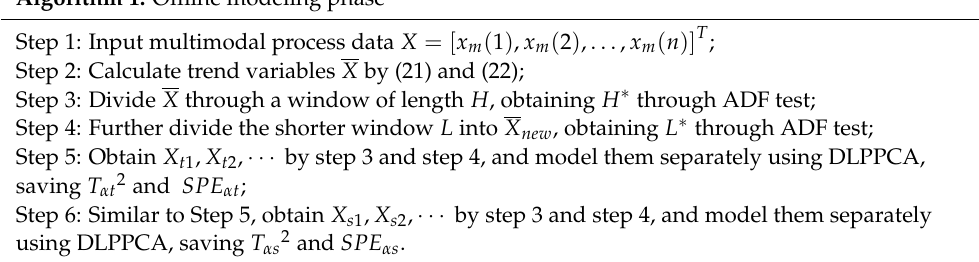
Algorithm 1. Offline modeling